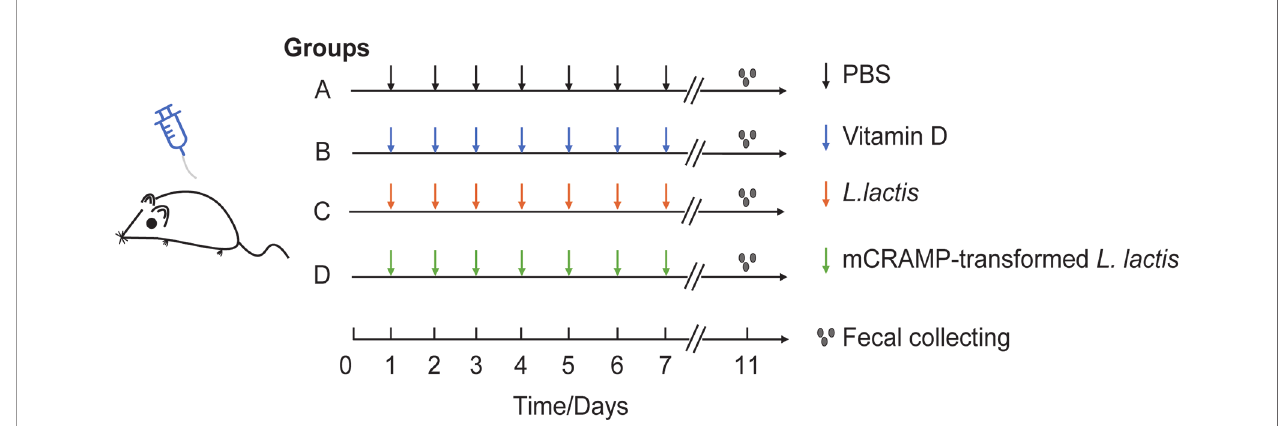
FIGURE 1 | Experimental design for mice model. Mice in group A, B, C, and D were orally given PBS (100 m l), VD (25 m g/kg), L. lactis (10 10 cfu/mouse), or mCRAMP-encoding L. lactis (10 10 cfu/mouse), respectively, every day from day 1 to day 10. Stool samples were collected on day 11 morning for further